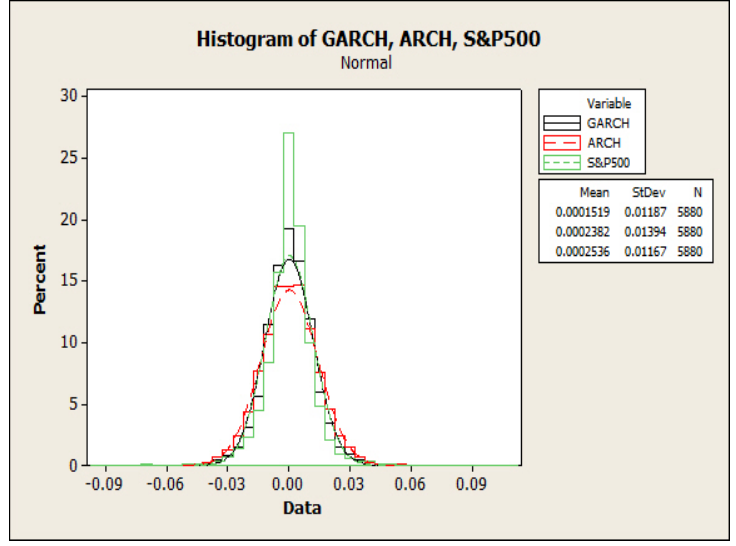
Figure 15. Density